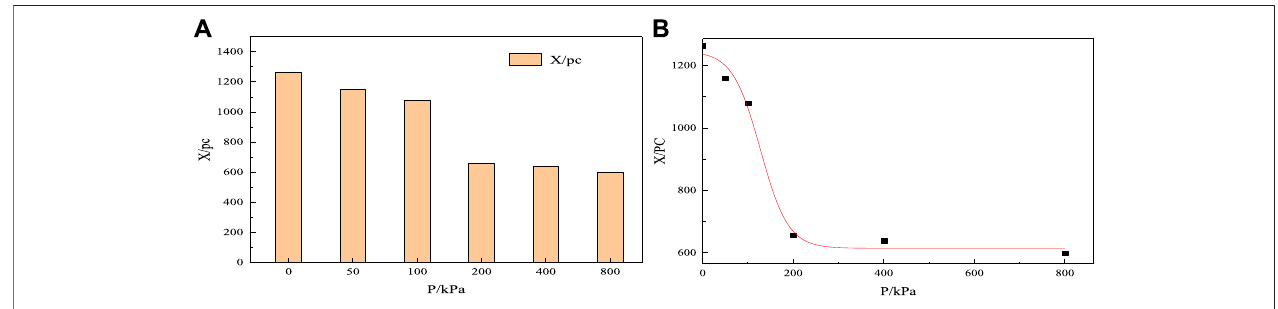
FIGURE 5 | Relation between pore number and consolidation pressure. (A) Columnar distribution of pores, (B) Relationship between X and P.